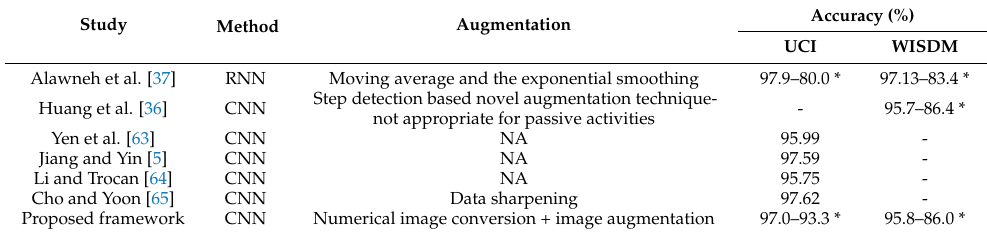
Table 15. Reference studies with benchmarking